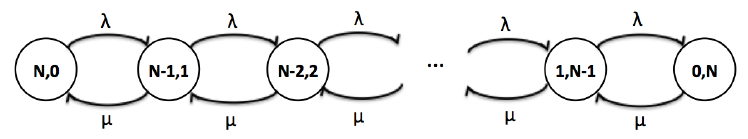
Figure 6. Markov chain for the minimum case with asynchronous access.